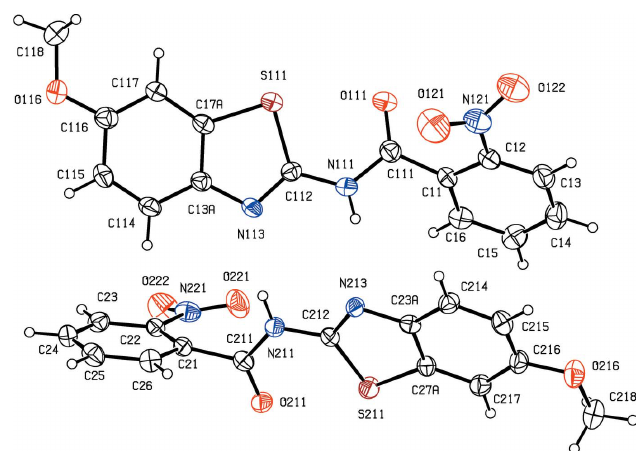
Figure 2 The structures of the two independent molecules in (II), showing the atom-labelling scheme. Displacement ellipsoids are drawn at the 30% probability